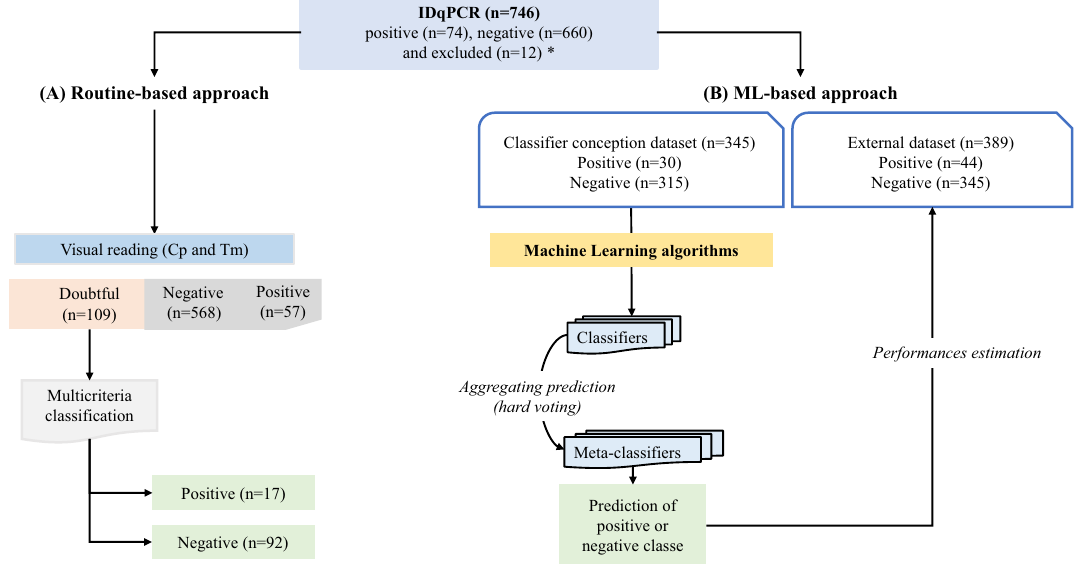
Figure 1. Design of the study for classification comparison of intercalating dye qPCR (IDqPCR) using two approaches ( A and B ). ( A ) “Routine based approach”: classification algorithm for intercalating dye qPCR (IDqPCR) based on the “visual reading” (with Tm for melting temperature and Cp for crossing point) and 2020 revised European Organization for Research and Treatment of Cancer and the Mycoses Study Group Education and Research Consortium (EORTC MSGRC) criteria 27 and ( B ) “Machine Learning based approach”: clinical data essential for